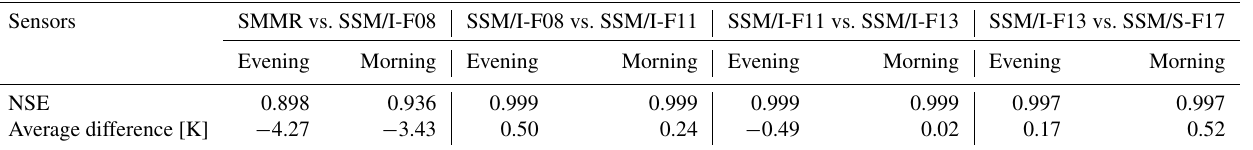
Table 3. Average enhanced-resolution T b differences at 37GHz, horizontal polarization, for the different PMW sensors and NSE coefficients computed for the histograms of T b .